Question: Compose a caption that would accompany this figure in a paper.
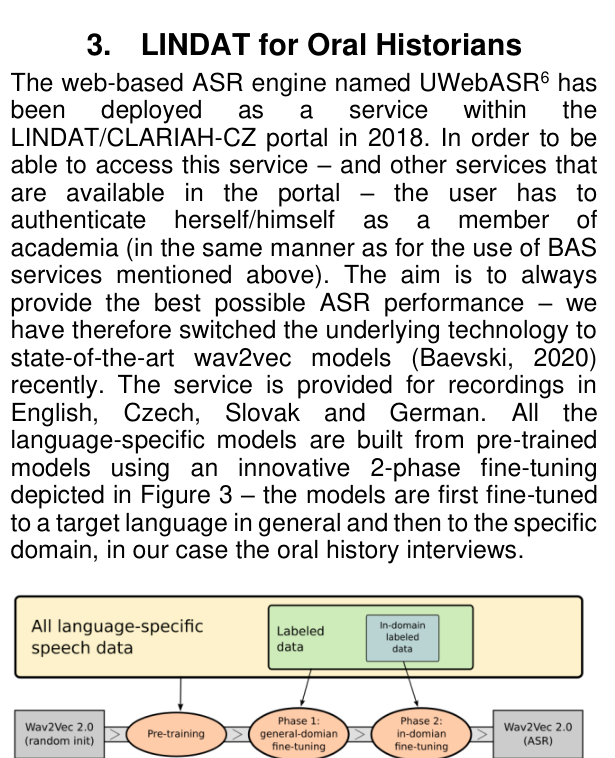
Answer: The scheme of 2-phase fine-tuning      The fine-tuning procedure was the same for all the  languages, one of the key differences is in the choice  of pre-trained model. For English, the model from  Meta AI (wav2vec2-base) was used. For Czech and  German, we have pre-trained our own model from  scratch. The Czech model named ClTRUS7 was then